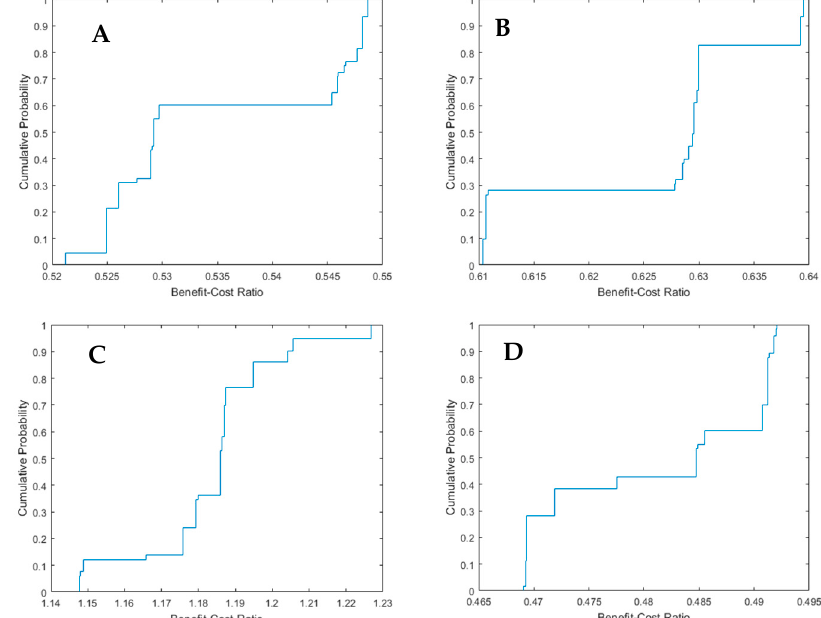
Figure 5. Empirical Cumulative Distribution Function of the Benefit-Cost Ratios for paths D (subfigure ( A )), H (subfigure ( B )), L (subfigure ( C )), and Q (subfigure ( D )).